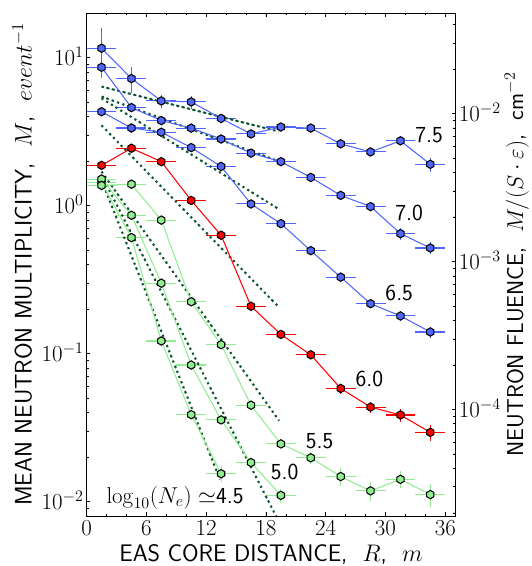
Figure 2. Lateral distributions of the mean multiplicity and cor- responding integral flux of low-energy (thermal) neutrons around the EAS core region. The numbers above the curves is the aver- age decimal logarithm of the size of the corresponding showers N e .